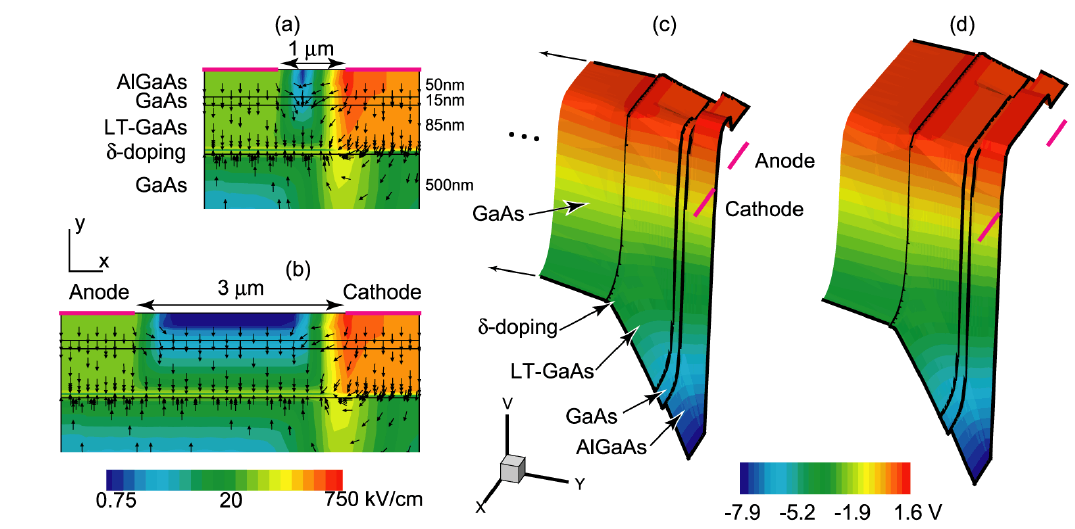
Figure 2. Electric field distribution in devices with 1- µ m ( a ) and 3- µ m ( b ) electrode spacings under 9 V applied bias. The layer structure is also shown in the vertical axis, and has a different scale from horizontal axis. Vectors show the calculated direction of the electric field. The electrostatic potential diagrams for the 1- µ m ( c ) and 3- µ m ( d ) detail the effects of the Schottky contact, bias, and the δ -doping